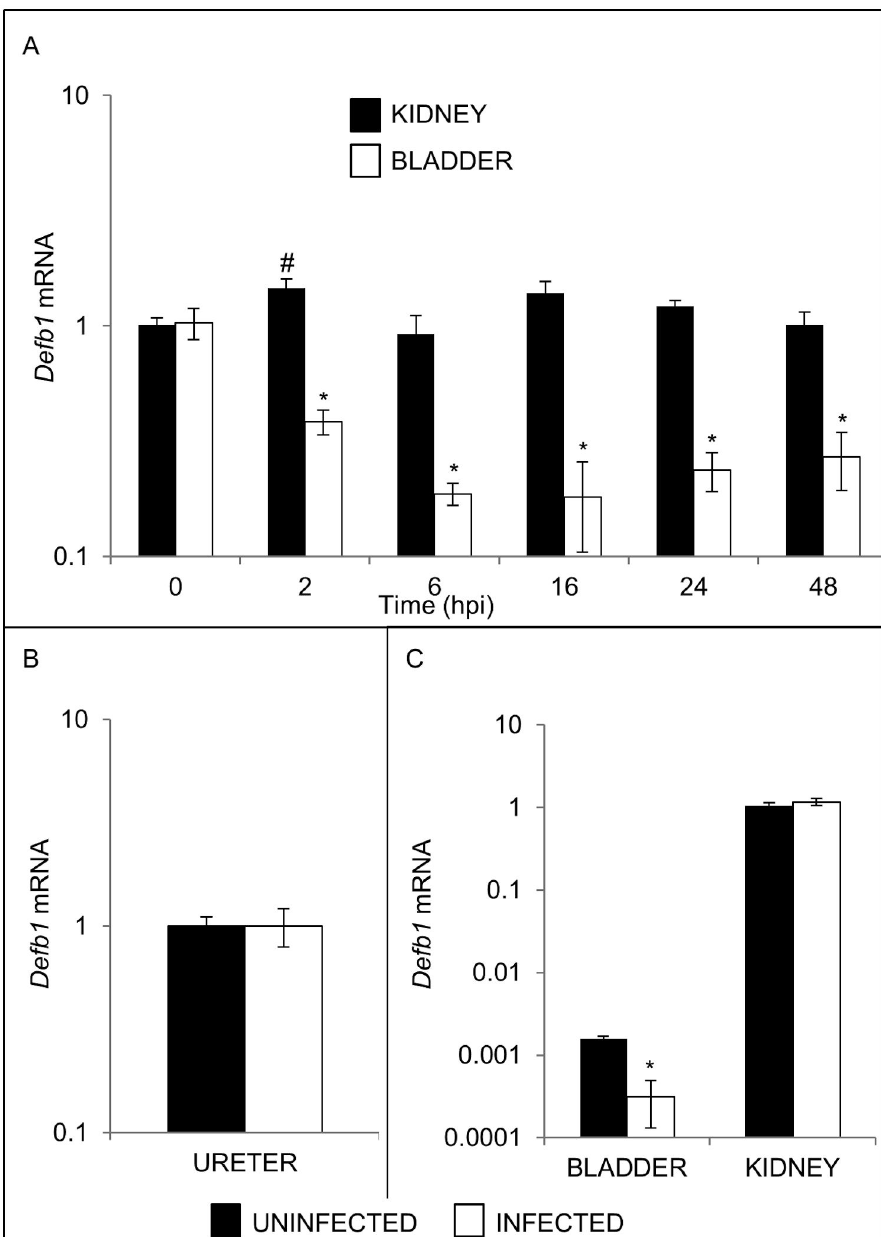
Figure 3. Effect of UPEC infection on Defb1 mRNA expression. (A) Timecourse of Defb1 mRNA expression in bladders (open boxes) versus kidneys (shaded boxes) of UPEC infected mice. Time in hpi is indicated on the X axis. Samples were normalized for Gapdh mRNA expression and compared to a pool of uninfected bladder or kidney cDNA using the 2^-ΔΔCT method[22]. Means ± S.E.M. are shown (n=4 bladders and 4 kidneys/group) * p < 0.05, student’s t -test, indicated timepoint versus uninfected bladders; # p < 0.05, student’s t-test, indicated timepoint versus uninfected kidneys. (B) Defb1 mRNA was measured in ureters from uninfected C57BL/6 females (shaded box) and 16 hpi with UTI89 (open box). Samples were normalized for Gapdh content and expressed as fold-difference compared to a pool of uninfected mouse ureter cDNA using the 2^-ΔΔCT method. There was no significant difference in Defb1 expression between groups. (C) Bladder Defb1 mRNA expression is down-regulated in C3H/HeN mice 16 hpi, but kidney Defb1 mRNA levels are unchanged. Shaded boxes represent uninfected organs, and open boxes represent organs harvested 16 hpi. Samples were normalized for Gapdh mRNA expression and compared to a pool of uninfected kidney cDNA using the 2^-ΔΔCT method[22]. Means ± S.E.M. are shown (n=3 bladders and 3 kidneys/group) * p < 0.05, student’s t -test, naïve versus infected C3H/HeN bladders. doi: 10.1371/journal.pone.0077714.g003 PLOS ONE |